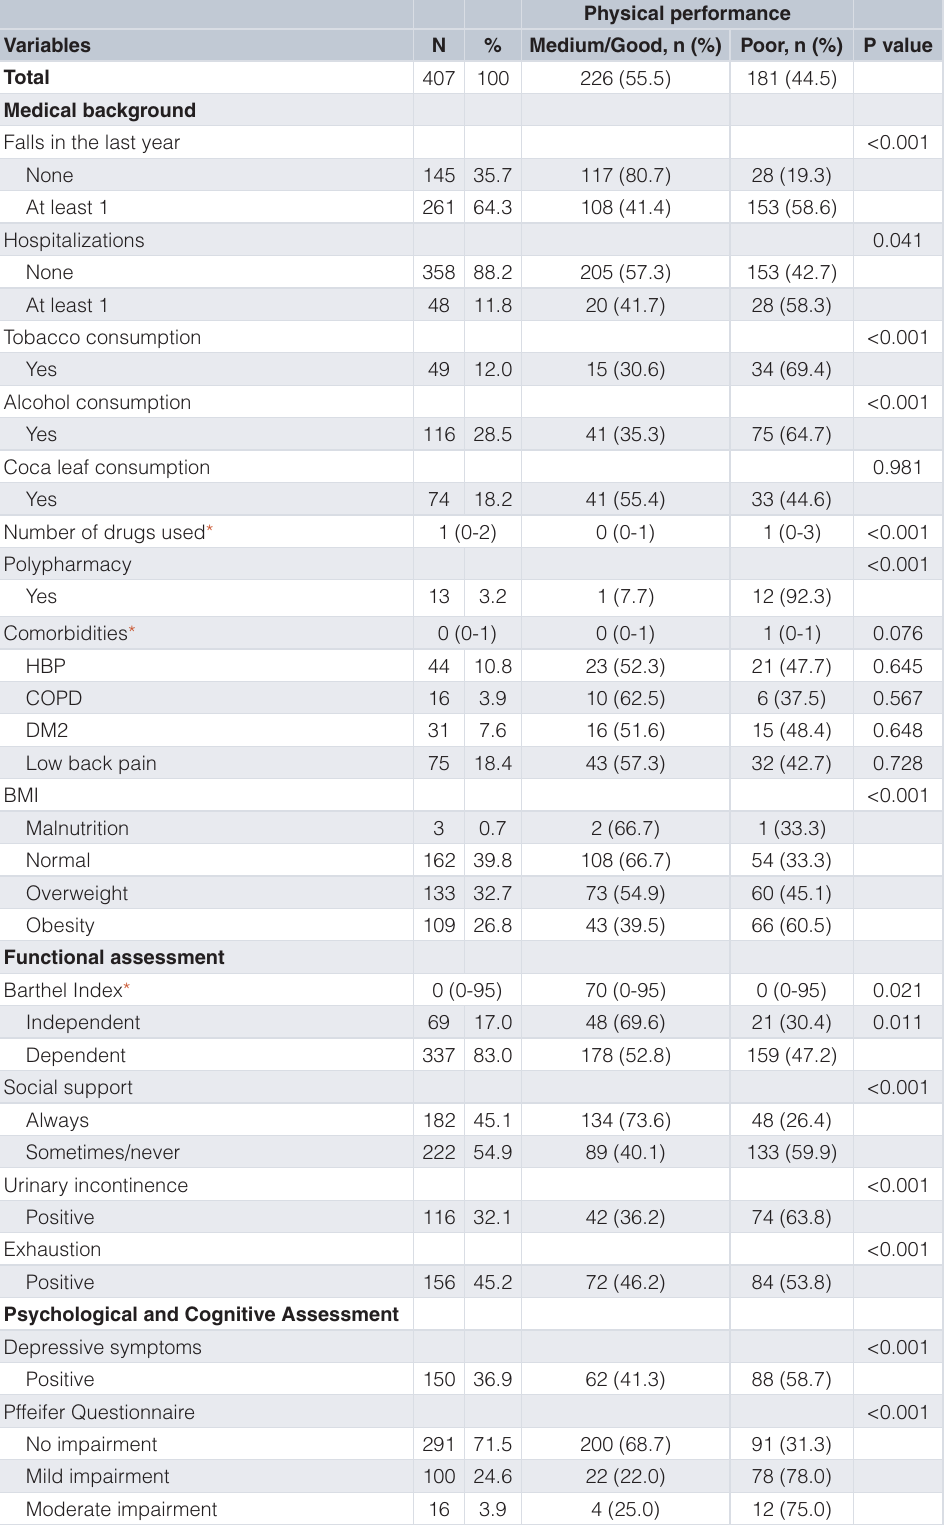
Table 2. Medical background, functional assessment and cognitive evaluation in the study sample and bivariate